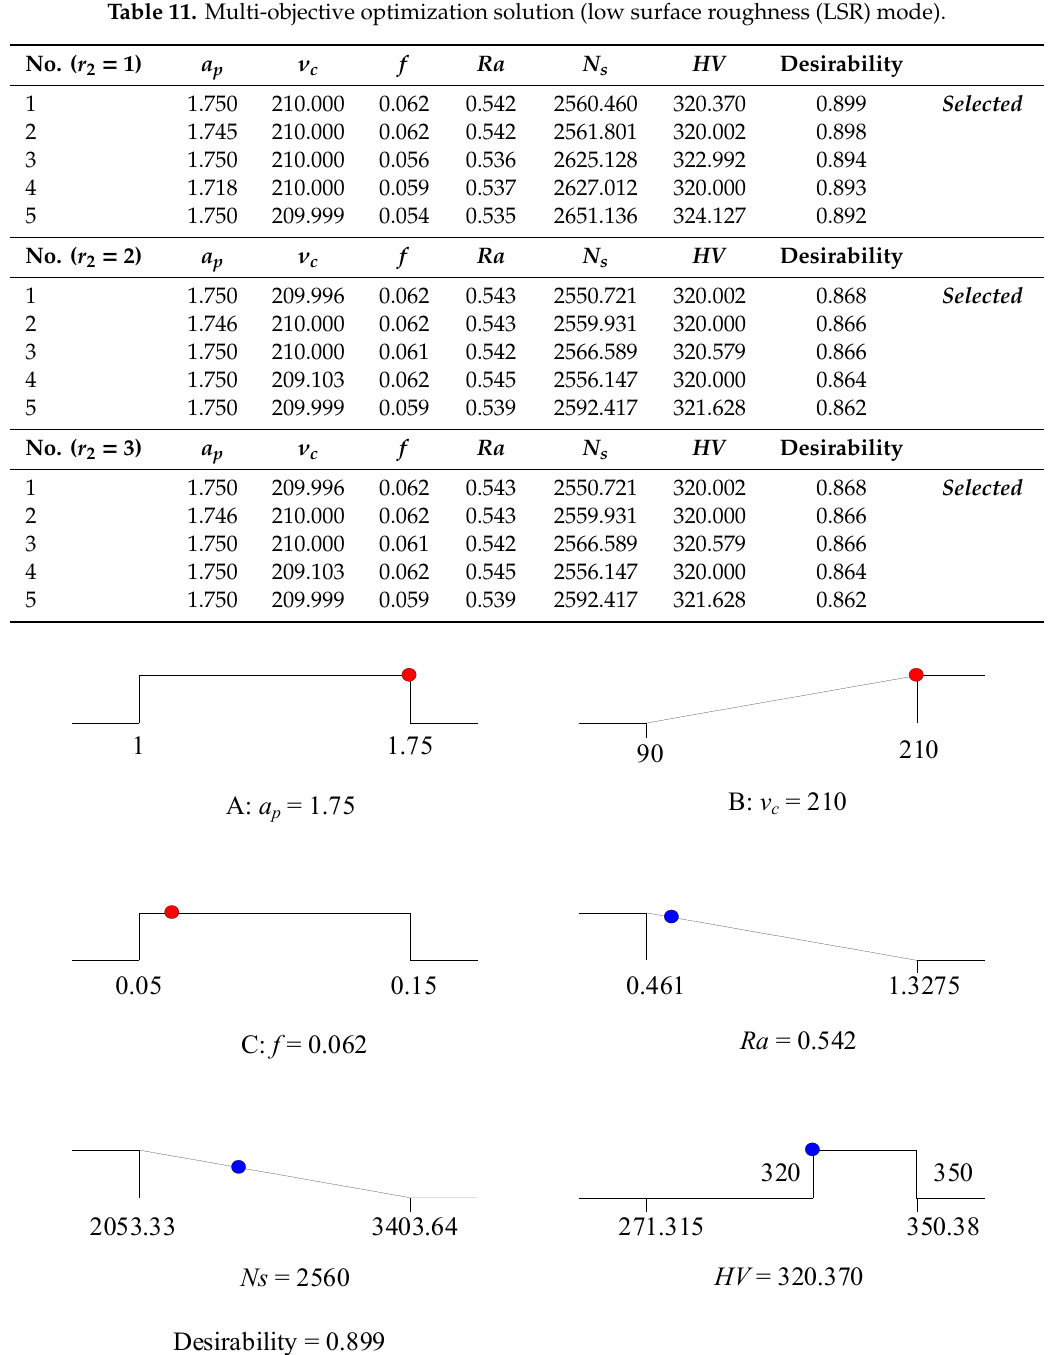
Figure 17. Ramp function graph of desirability (LSR mode) .